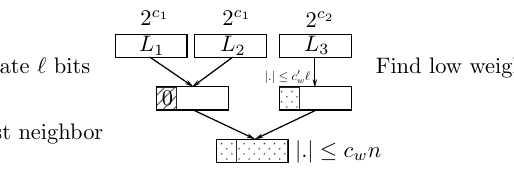
Figure 1: The Approximate 3-List